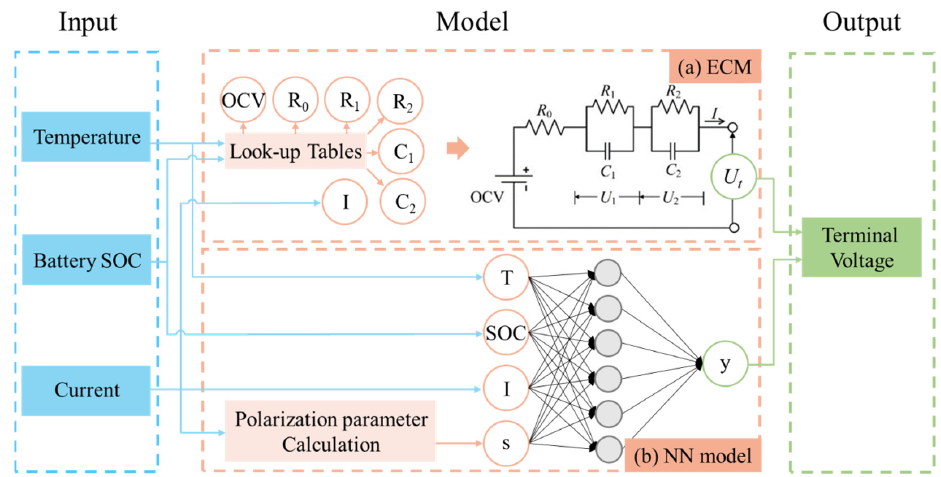
Figure 1. Battery models. ( a ) 2nd ‐ order ECM. ( b ) NN model.